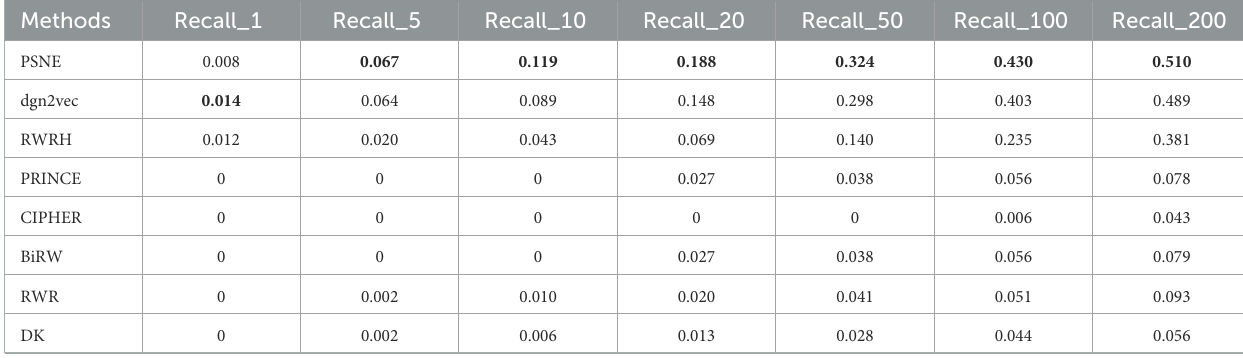
TABLE 5 For Parkinson’s disease, the performance evaluation of PSNE in terms of top-k Recall (k = 1, 5, 10, 50, 100, and 200), with comparison to the state-of-the-art methods. Methods